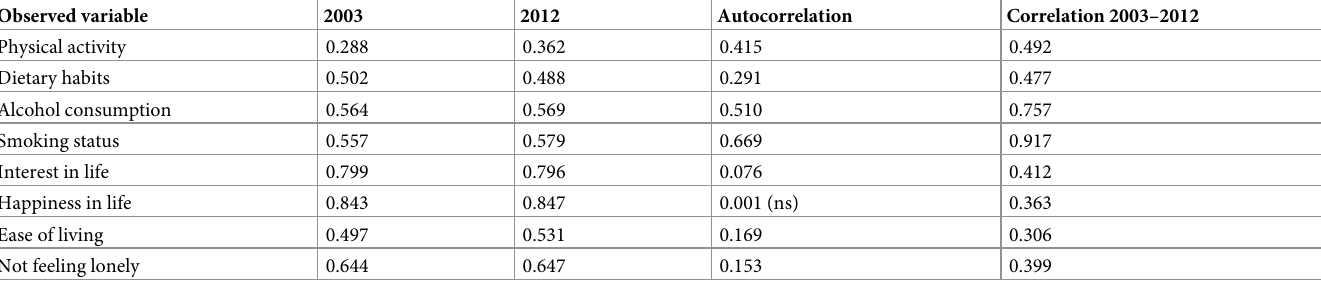
Table 5. Standardized path coefficients, correlations, and autocorrelations of observed